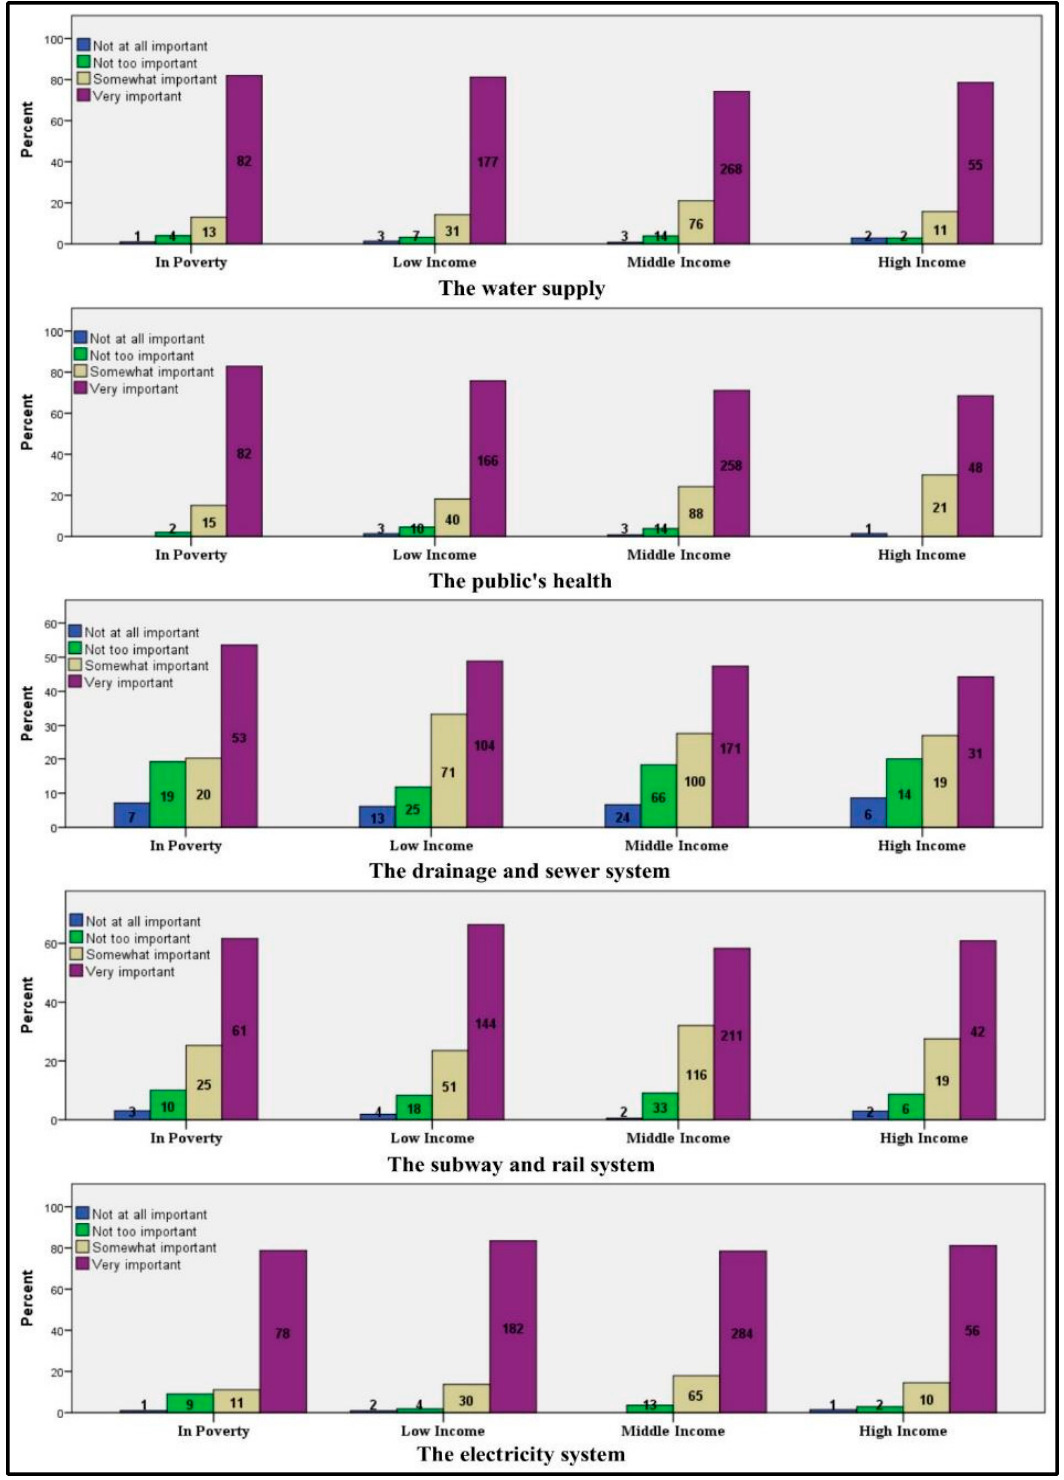
Figure A3. Importance of different urban sectors in heat wave adaptation based on income groups’ perception (the numbers inside the bars represent the number of responses in the data base).